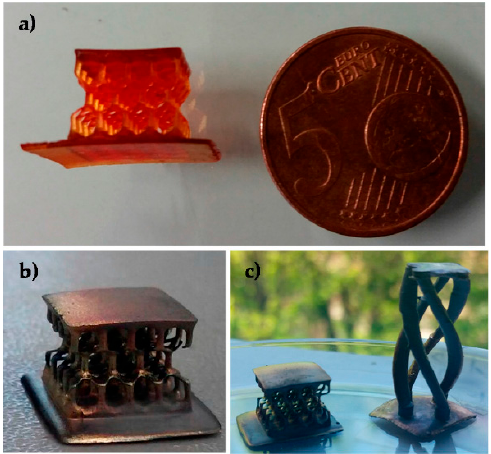
Figure 9. Three-dimensional objects produced by the DLP technique from the formulation containing polyethylene glycol diacrylate (PEGDA) and 15 phr of silver nitrate. ( a ) Honeycomb structure, as printed; ( b , c ) samples after the thermal treatments; the metallic aspect induced by the presence of the silver nanoparticles is clearly visible. Reprinted from [37], © 2016, with permission from MDPI AG.